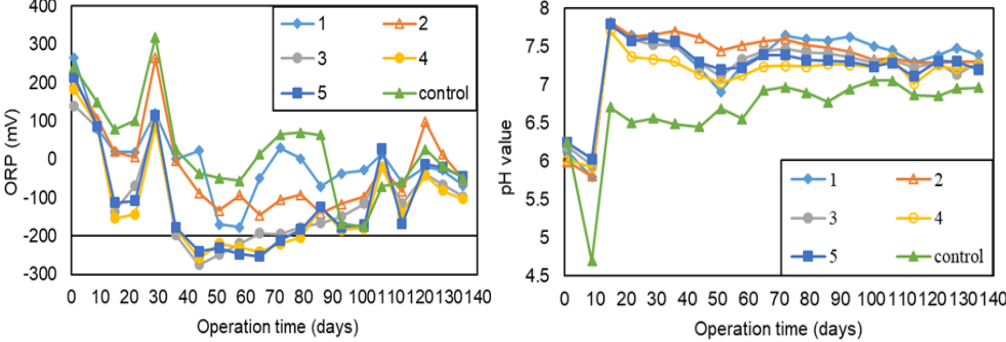
Figure 4. The changes of oxidation-reduction potential (ORP) and water pH values in microcosm during the operation.